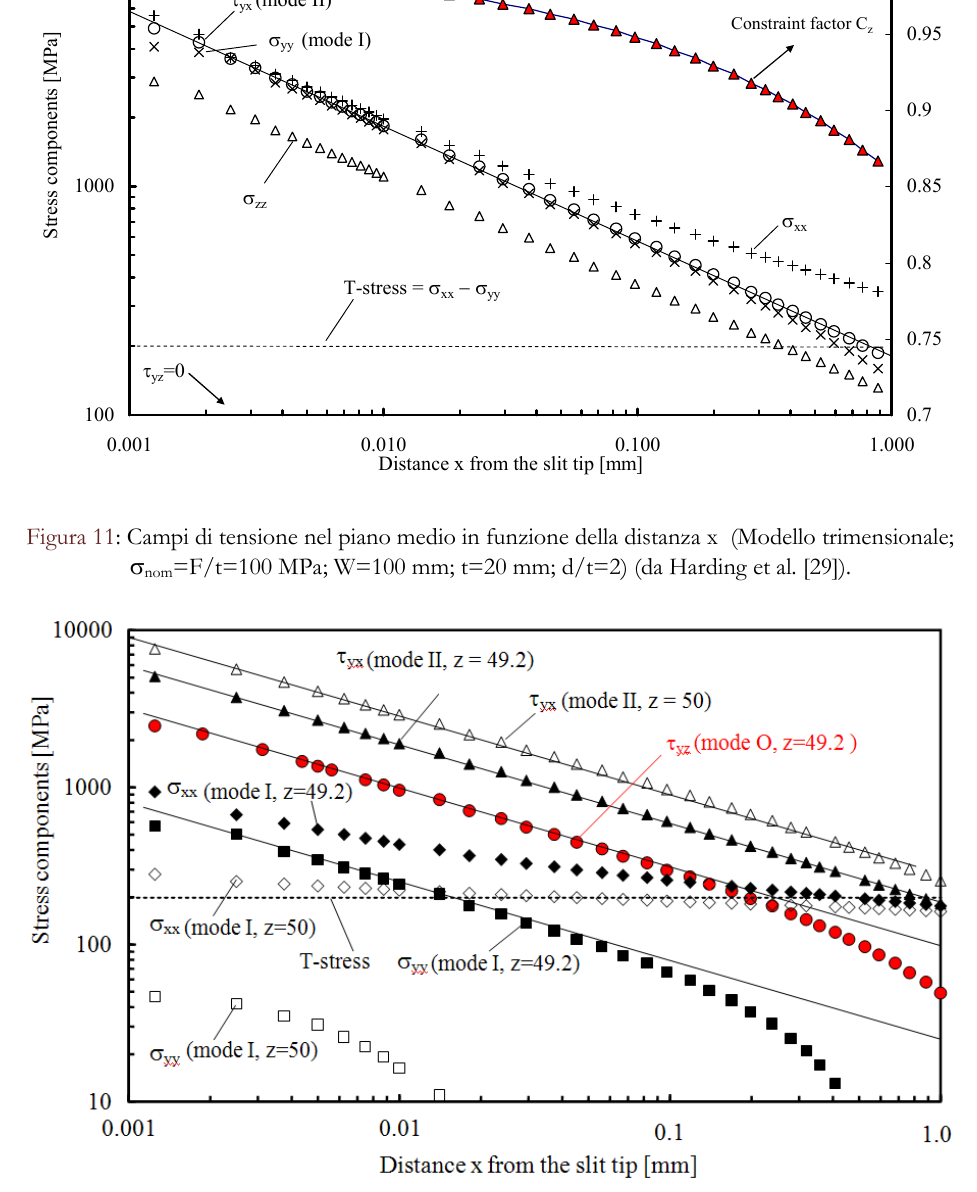
Figura 12: Componenti di tensione in due diversi piani in funzione della distanza x dal punto di singolarità: tensioni sulla superficie laterale del giunto (z=50 mm) e su una superficie immediatamente adiacente (z=49.2 mm). Stessa geometria di figura precedente (da Harding et al.